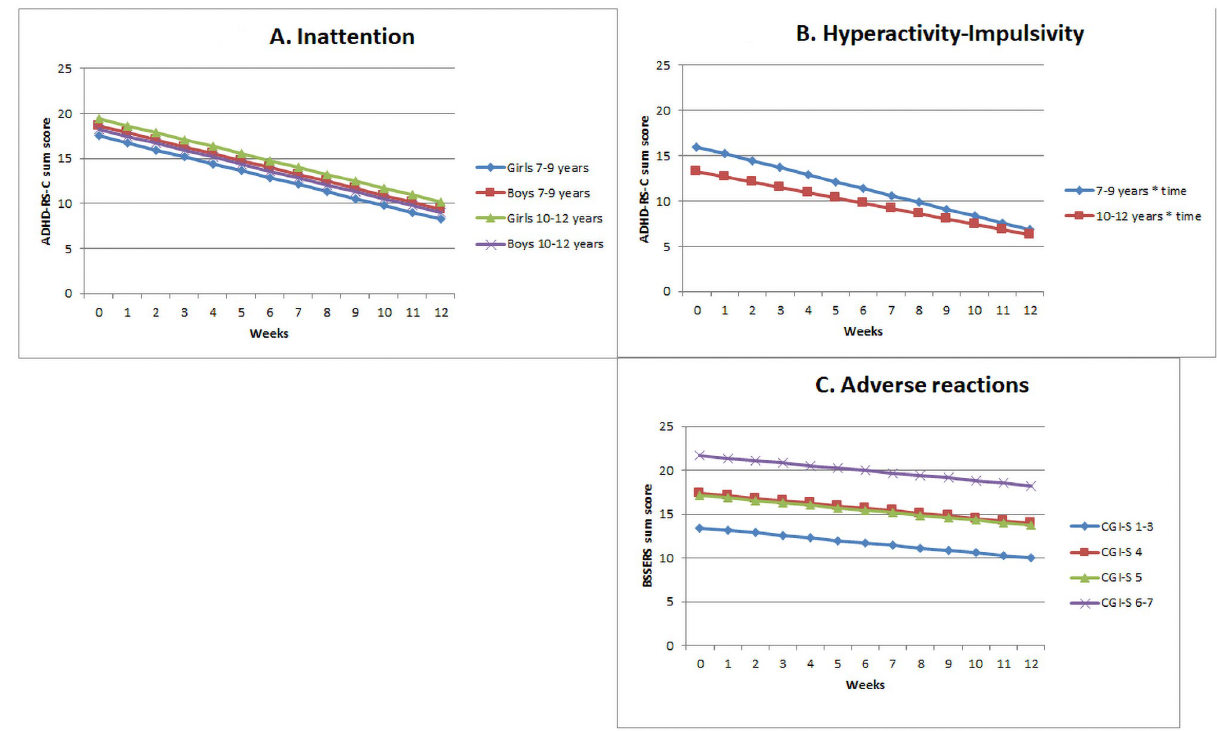
Fig 2. Examples of graphs for estimations sum scores of inattention, hyperactivity-impulsivity, and adverse reactions throughout the 12 weeks as estimated by the linear mixed models, n = 207. Clinician rated ADHD-Rating-Scale (ADHD-RS-C); Inattention subscale, 9 items [range 0–27] and Hyperactivity-Impulsivity subscale, 9 items [range 0–27]. Clinician rated Barkley’s Stimulant Side Effect Rating Scale (BSSERS-C), 17 items, [range 0–153]. Explanatory variables: Sex, age (7 to 9 years and 10 to 12 years), functional impairments in week 0, and Clinical Global Impression Severity (CGI-S). CGI-S devided into: 1–3 = Not ill , borderline ill , mildly ill . CGI-S 4 = Moderately ill , CGI-S 5 = Markedly ill . CGI-S 6–7 = Severly ill , among the most extreme ill patients .